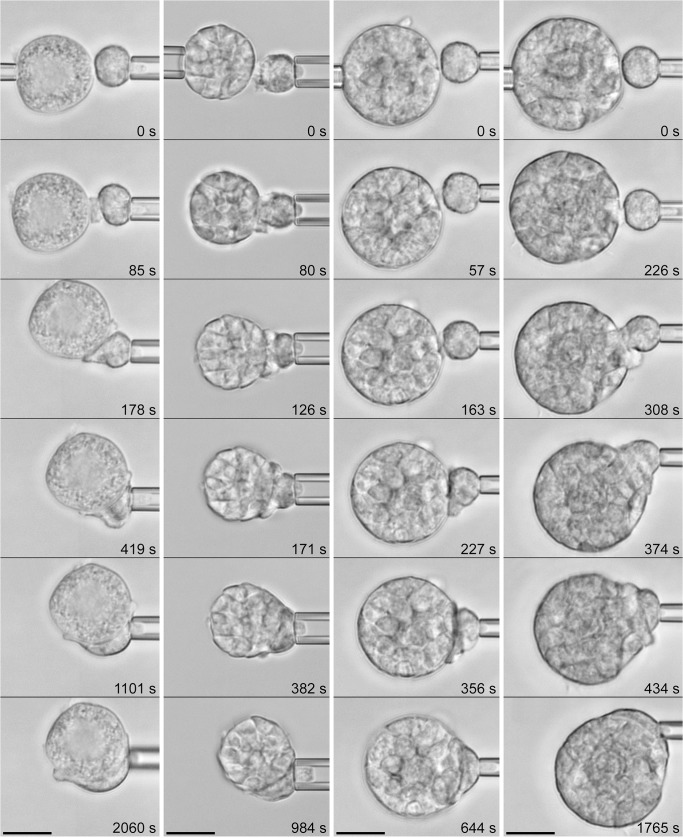
Phagocytosis of C. posadasii spherules by initially passive human neutrophils.(See also S3 Video and S4 Video.) Four example experiments are presented as vertical filmstrips. (The spherule in the first panel is immature [71].) The experimental conditions were the same as in Fig 4. The relative times of all video images are included. Table 1 summarizes the number of experiments in which this behavior was observed. All scale bars denote 10 μm.